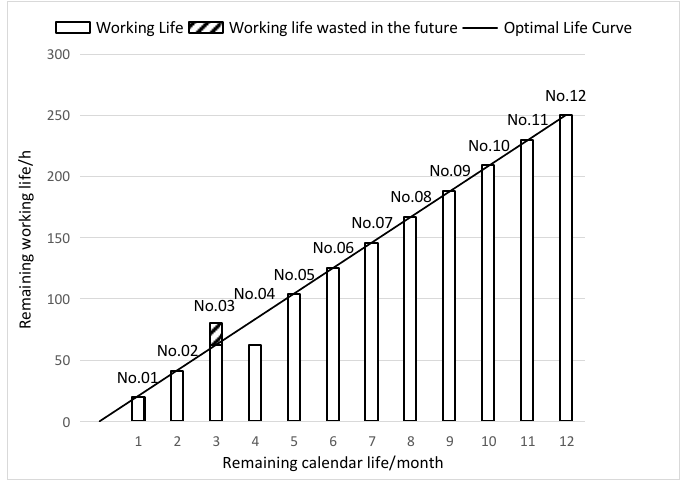
Figure 2. Echelon usage diagram with M = N . From the number of units used, M = N , it can be seen that the working life consump- tion of each equipment item per month is Ty ÷ M